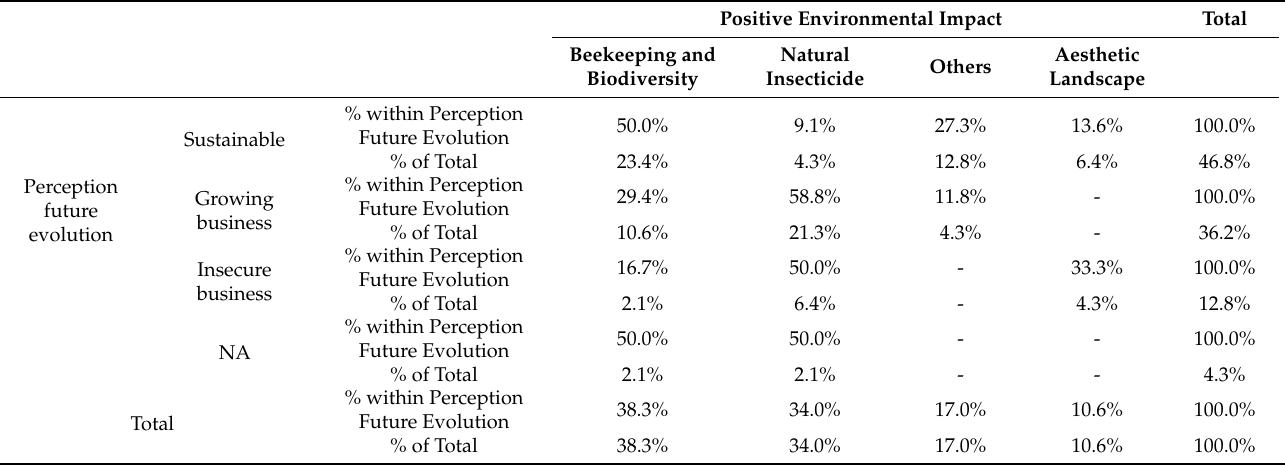
Table 10. Crosstabulation between the perception of civil servants with agricultural expertise regard- ing the future evolution of lavender farming and their positive environmental